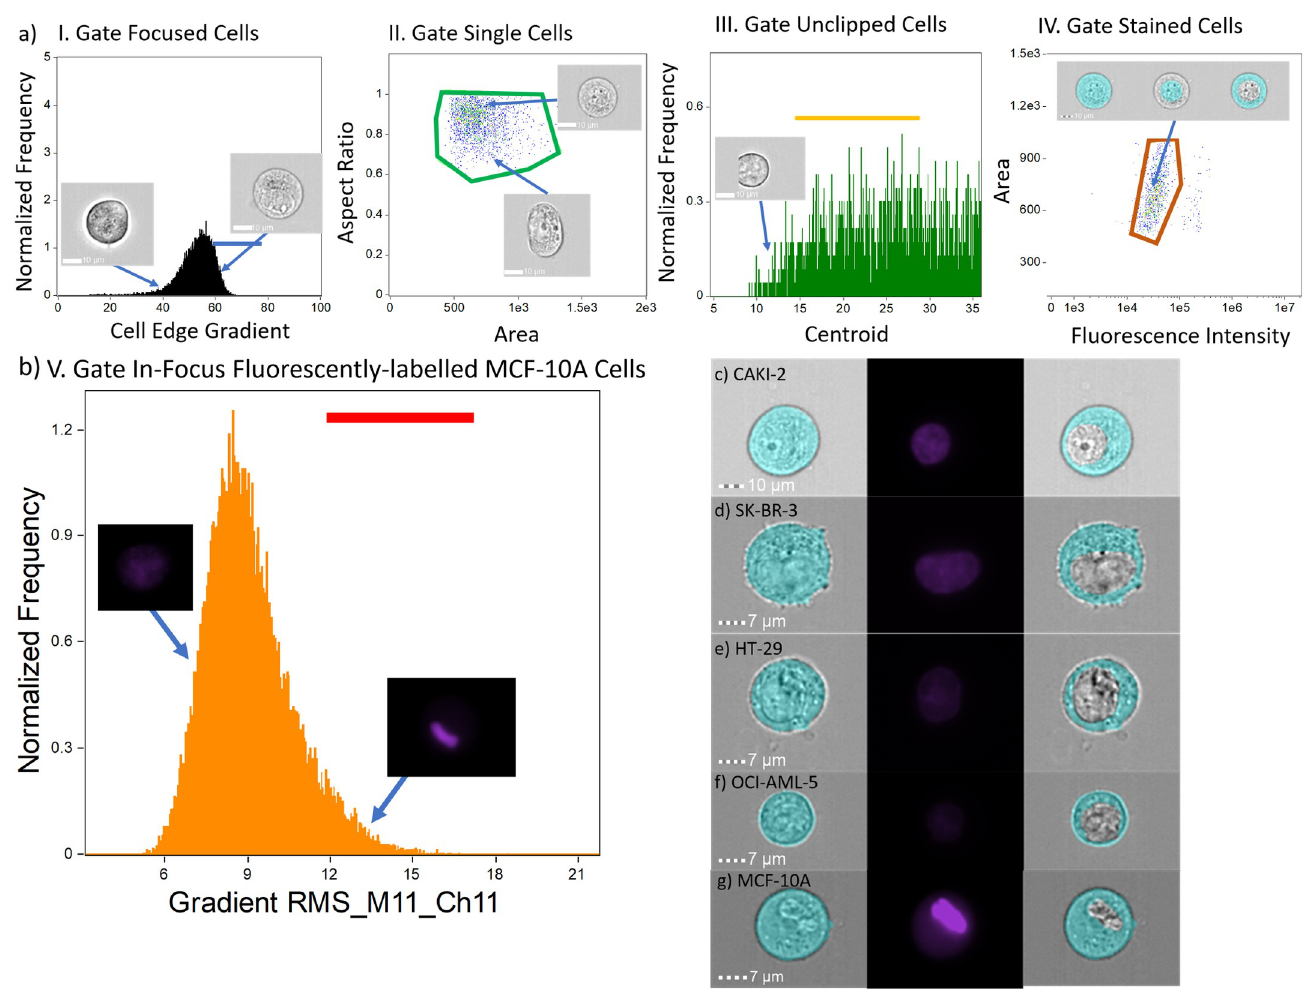
Fig 1. IFC analysis workflow and representative cells. (a) The IFC analysis workflow excludes: (I) unfocused cells, (II) multiple cells per brightfield image, (III), clipped cells in brightfield images, (IV) unstained cells. Sequential gating bars (I–blue, II–green, III–yellow, IV–orange) depict manually gated ROIs for each cell population. (b) Additional gating step for MCF-10A cells to address leakage due to extended trypsinization. (c-g) Representative cells from each cell line after IFC gating cell mask (left column), stained fluorescent image (middle column), and cytoplasm (right